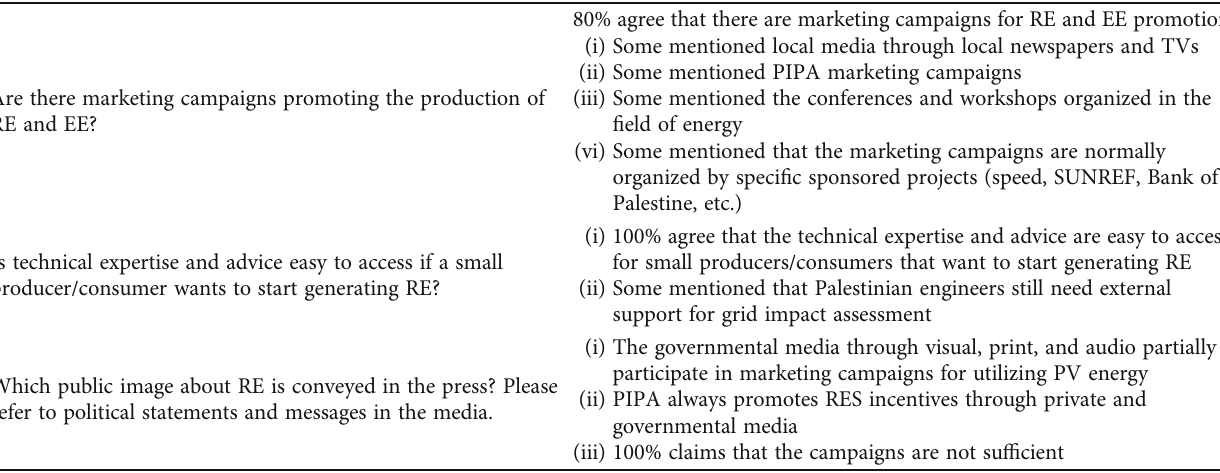
Table 7: Summarization of answers of public institutions about promotion and information.